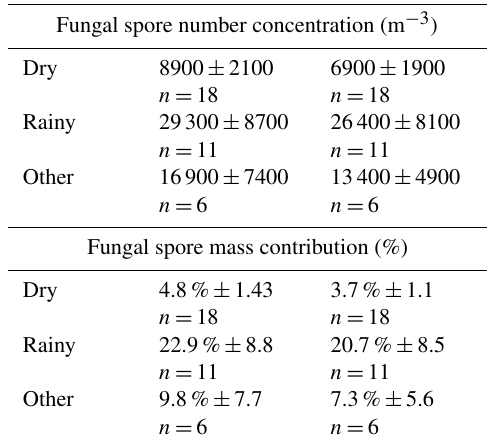
Table 4. Campaign-average fungal spore concentration and mass contribution estimated from arabitol and mannitol mass measure- ments. Values are mean ± standard deviation; n shows number of samples used for averaging. Fungal spore mass assumption of 33pgspore − 1 (Bauer et al., 2008b). Total particulate matter mass calculated from UV-APS number concentration (m − 3 ), converted to mass over aerodynamic particle diameter range 0.5–15µm using 1.5gcm − 3 density.